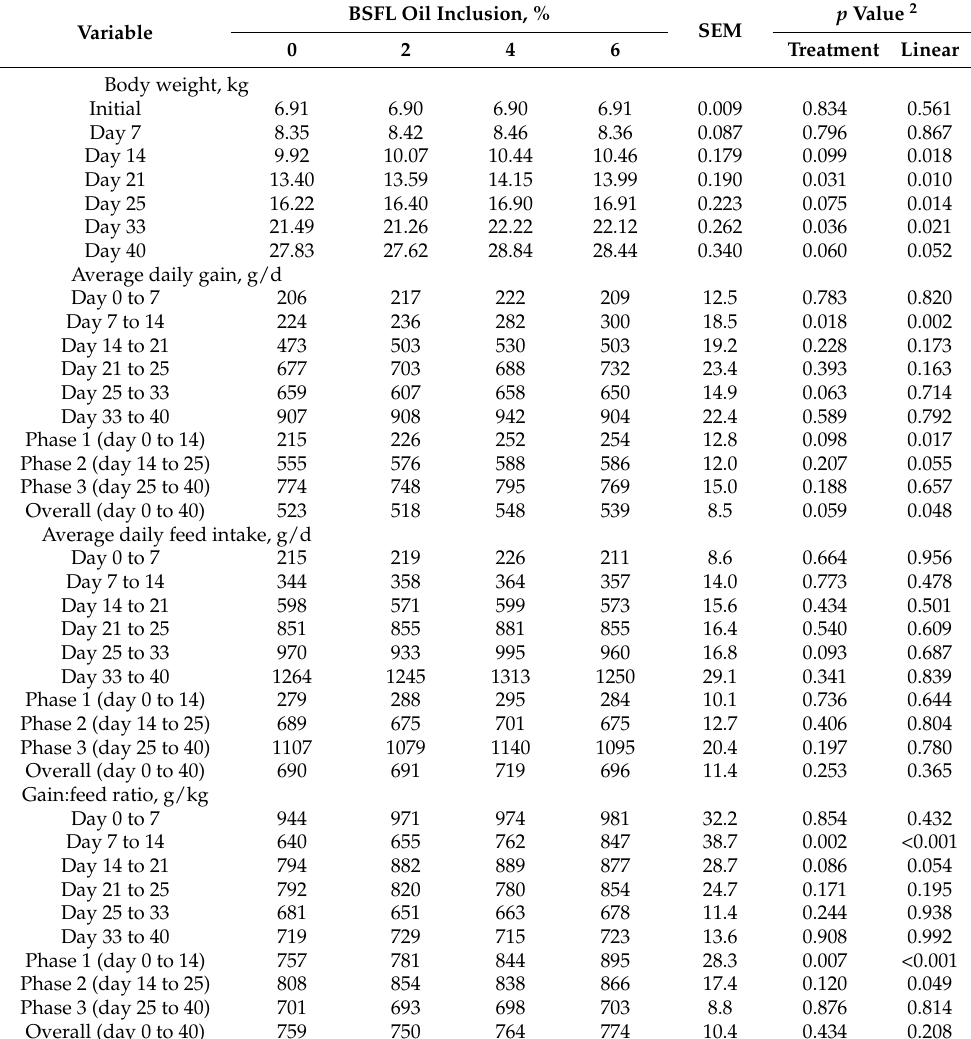
Table 4. Growth performance of nursery pigs fed diets with increasing levels of black soldier fly larvae (BSFL) oil replacing equal amounts of corn oil 1